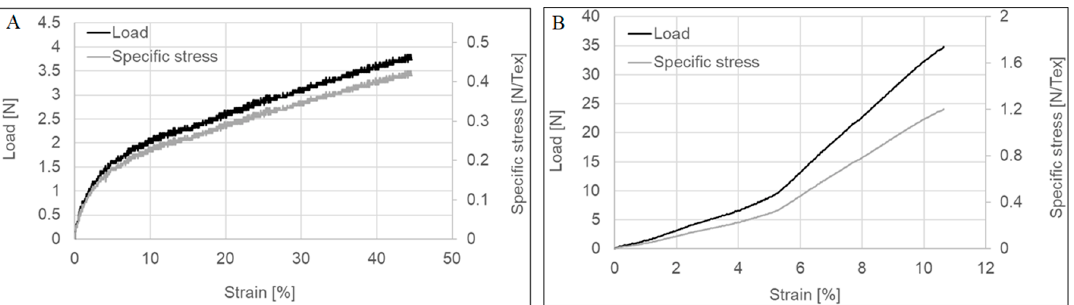
Table 1. Mechanical properties of carbon nanotube yarns (CNTYs) during single axial stretching.